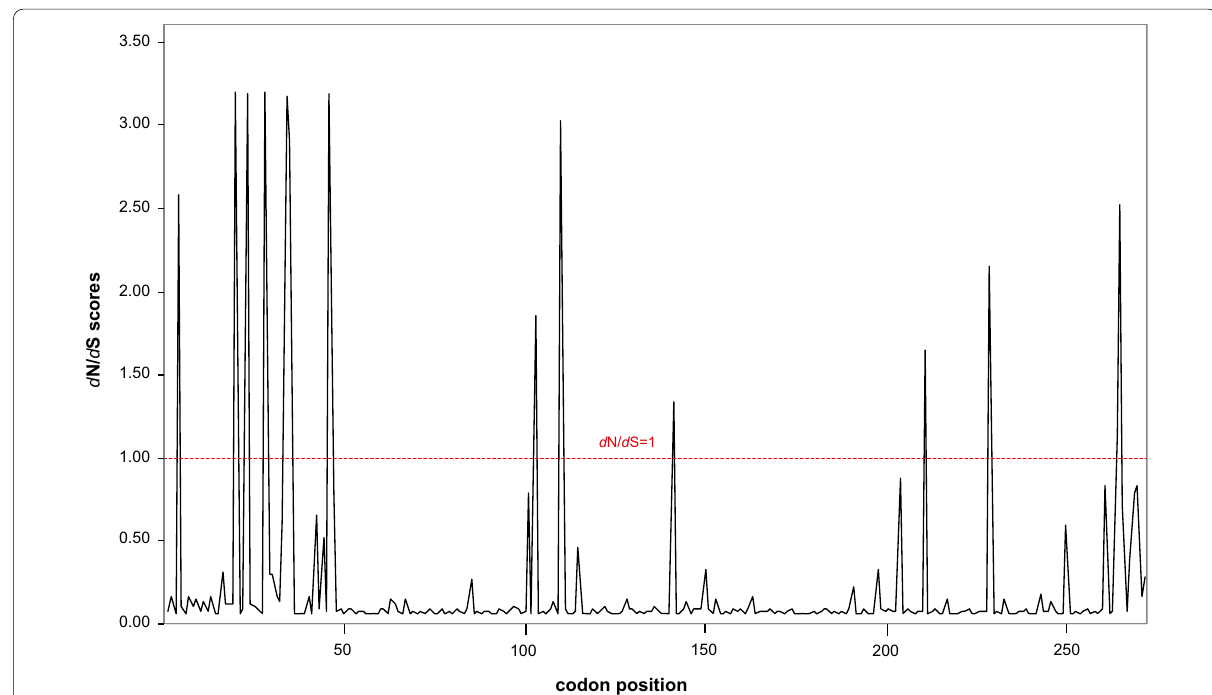
Fig. 3 Sliding windows analysis for the d N/ d S ratios produced by the site models of CodeML implemented in EasyCodeML. A red dotted line represents where d N/ d S 1, consistent with the neutral expectation =